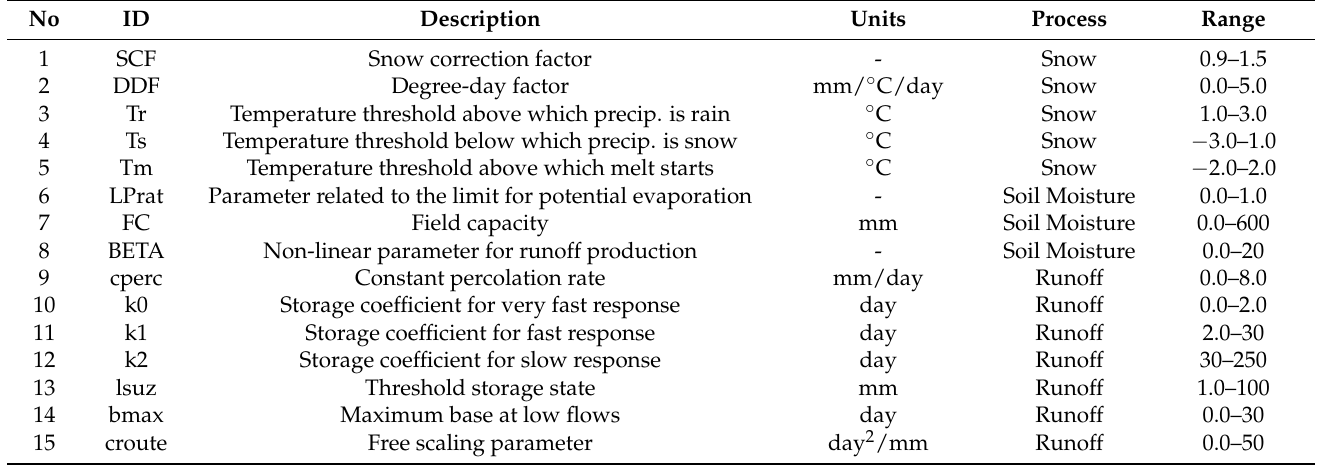
Table 3. TUW model parameter